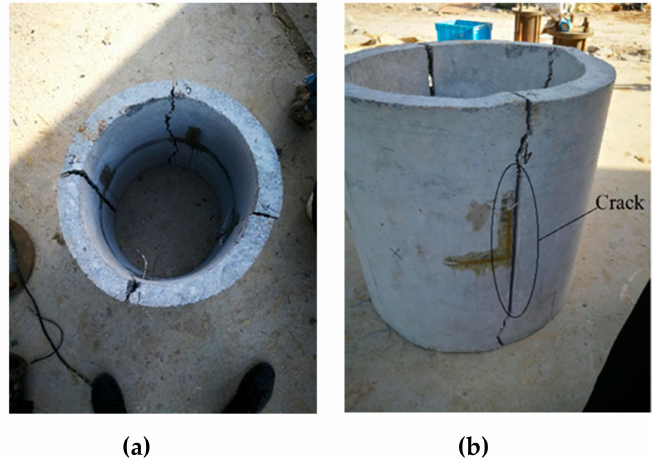
Figure 10. ( a ) Intact concrete pipe and ( b ) cracked concrete